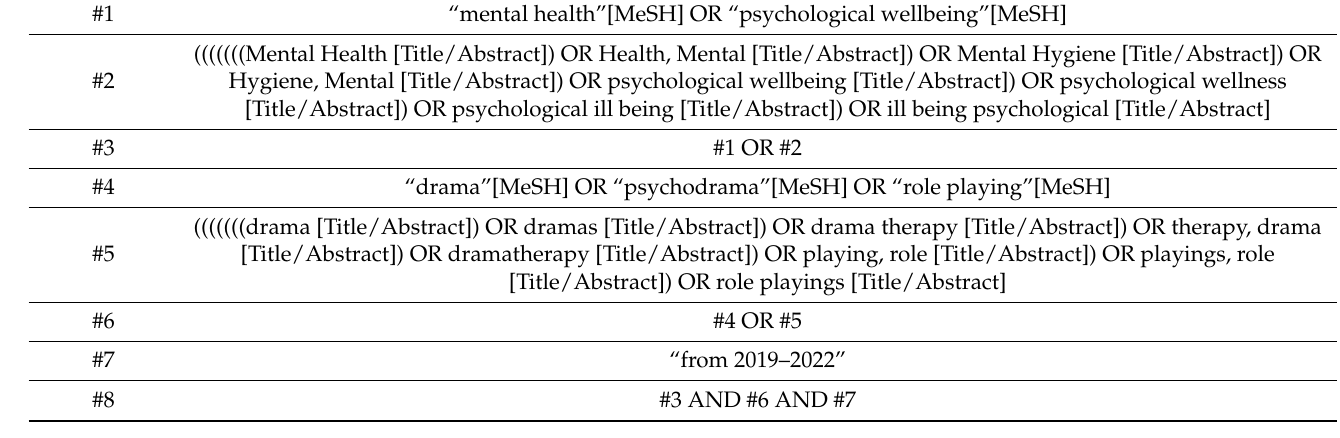
Table 1. Search strategy on